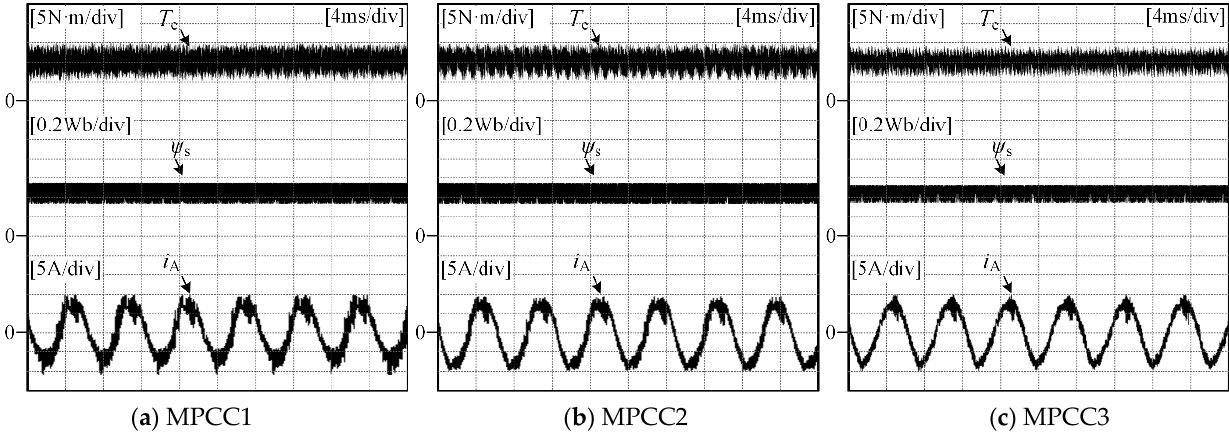
Figure 10. Experimental results of MPCC1, MPCC2 and MPCC3 (case 2).